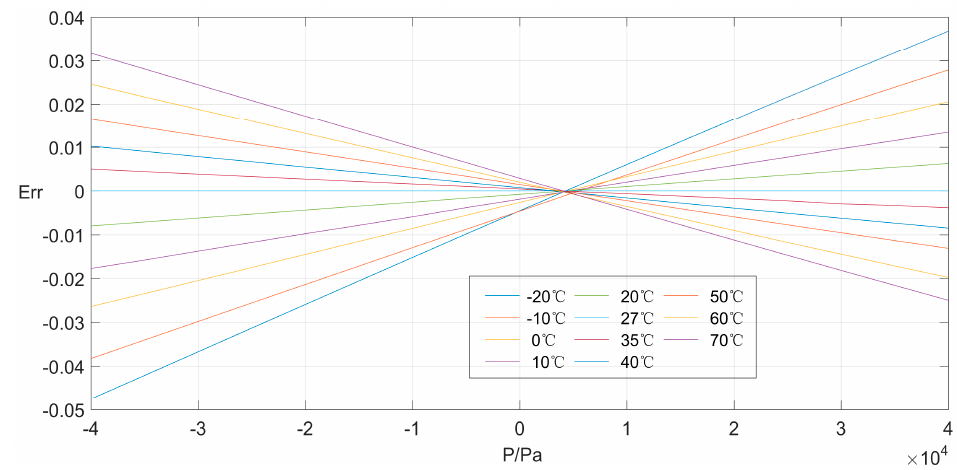
Figure 6. Relative error of pressure sensor with the benchmark data at 27 °C.